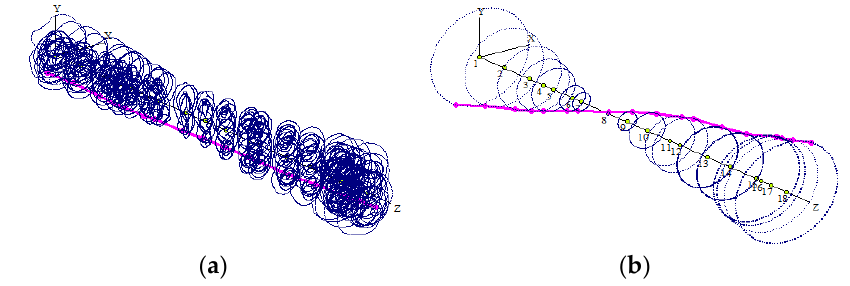
Figure 16. Vibration modes in different time periods: ( a ) 0.05–0.08 s; ( b ) 1–1.5 s.